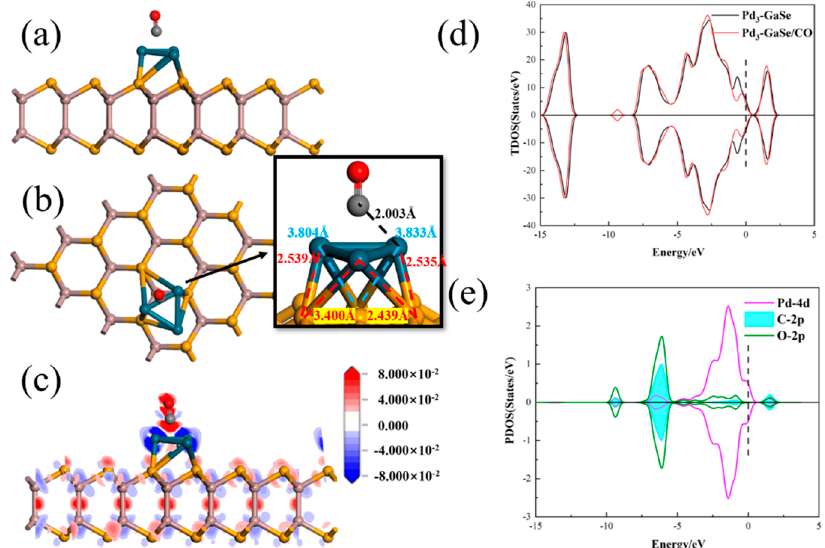
Figure 10. Adsorptive structure of Pd 3 -GaSe/CO system ( a ) view of side, ( b ) view of top, ( c ) DCD distribution, ( d ) TDOS of Pd 3 -GaSe/CO system, ( e ) PDOS of Pd 3 -GaSe/CO system.